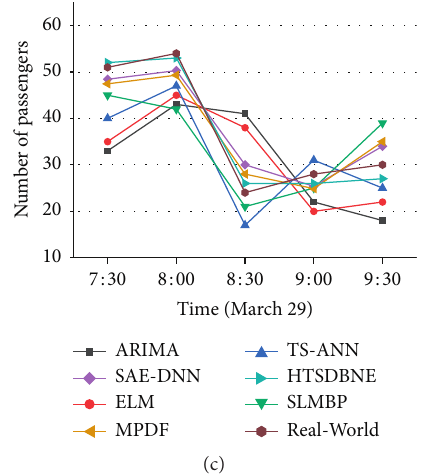
Figure 15: Comparison between HTSDBNE and other models in the morning peak hours of working days (station 7 of line